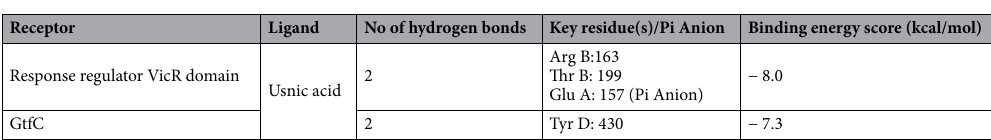
Figure 5. Effect of sub-MIC levels of UA on the gene expression of key virulence and quorum sensing regulators of S. mutans. (A) Relative variation in the gene expression of S. mutans under the influence of 2.5 µg mL −1 concentration of UA compared to the untreated control. ( B–Hii) substantiation of variation in gene expression through physiological assays. (B) and (C) Effect of UA on acidogenic potential of S. mutans which is under the control of ComDE (B-Glycolytic pH drop assay and C-pH of the spent medium) . UA at sub-MIC, MIC and MBC significantly inhibited the glycolytic pH drop. Also, acidic nature of the broth was found to be increasing with UA treatment. (D) Effect of UA on acid tolerance of S. mutans at sub-MIC levels. UA significantly inhibited the survival rate of S. mutans cells in acidic condition compared to untreated controls. (E) Sensitization of S. mutans cells to H 2 O 2 by the influence of UA treatment. (F) Repression of eDNA content in the UA treated biofilm matrix. (Gi–Hii) Binding pattern and molecular interaction of UA with vicR (Gi and Gii, 3D and 2D respectively) and gtfC (Hi and Hii, 3D and 2D respectively) . Data are mean ± SD (n = 3) and Asterisk represent significant difference compared with the untreated control ( p < 0.05).